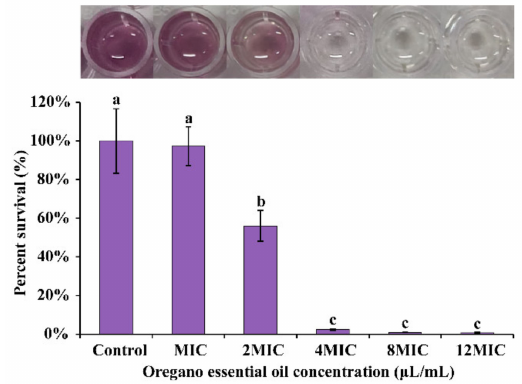
Figure 12. Effects of OEO on biofilm reduction and cell viability of E. faecalis ATCC 29212. Different lowercase letters indicate statistically significant differences between the means ( p < 0.05).